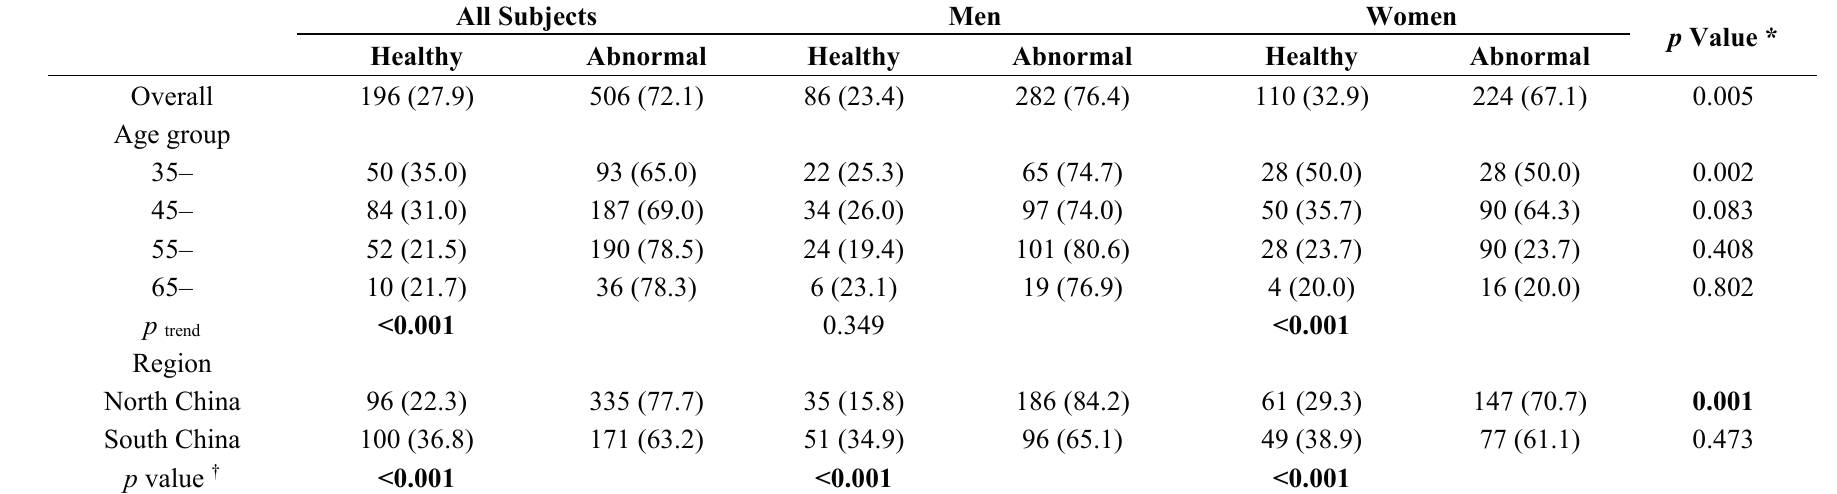
Table 2. Prevalence of metabolically healthy and abnormal in obese subjects stratified by age and gender.